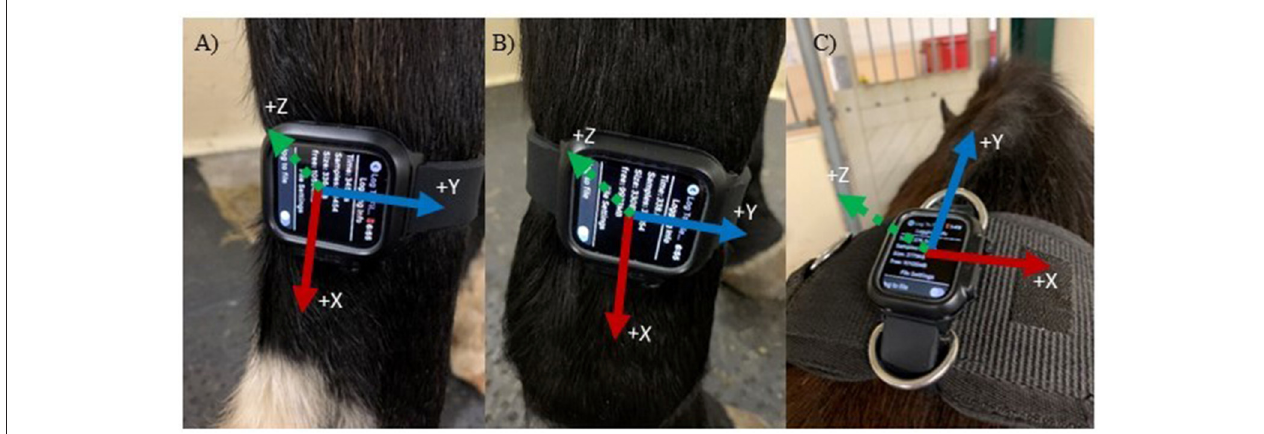
FIGURE 2 | Accelerometer axes based on sensor location and orientation. Axes are indicated in the positive directions. (A) Right Hindlimb (Y = anteroposterior, X = vertical and Z = mediolateral); (B) Right Frontlimb (same axes as A); (C) Withers (Y = anteroposterior, X = mediolateral and Z = vertical).